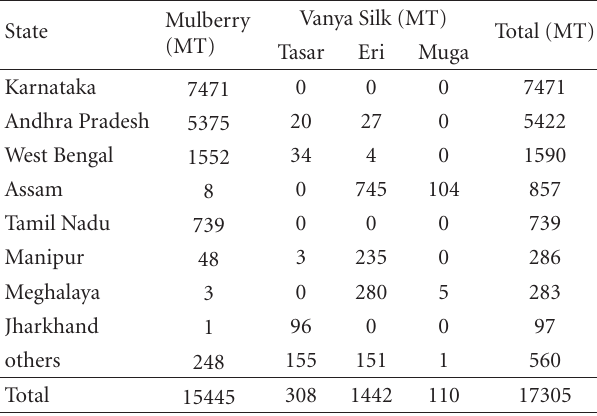
Table 1: Silk production in India